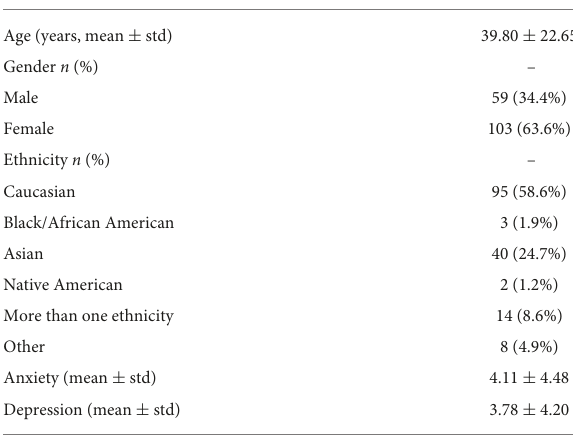
TABLE 1 Summary of participant demographics and mental health symptoms self-reported by healthy study